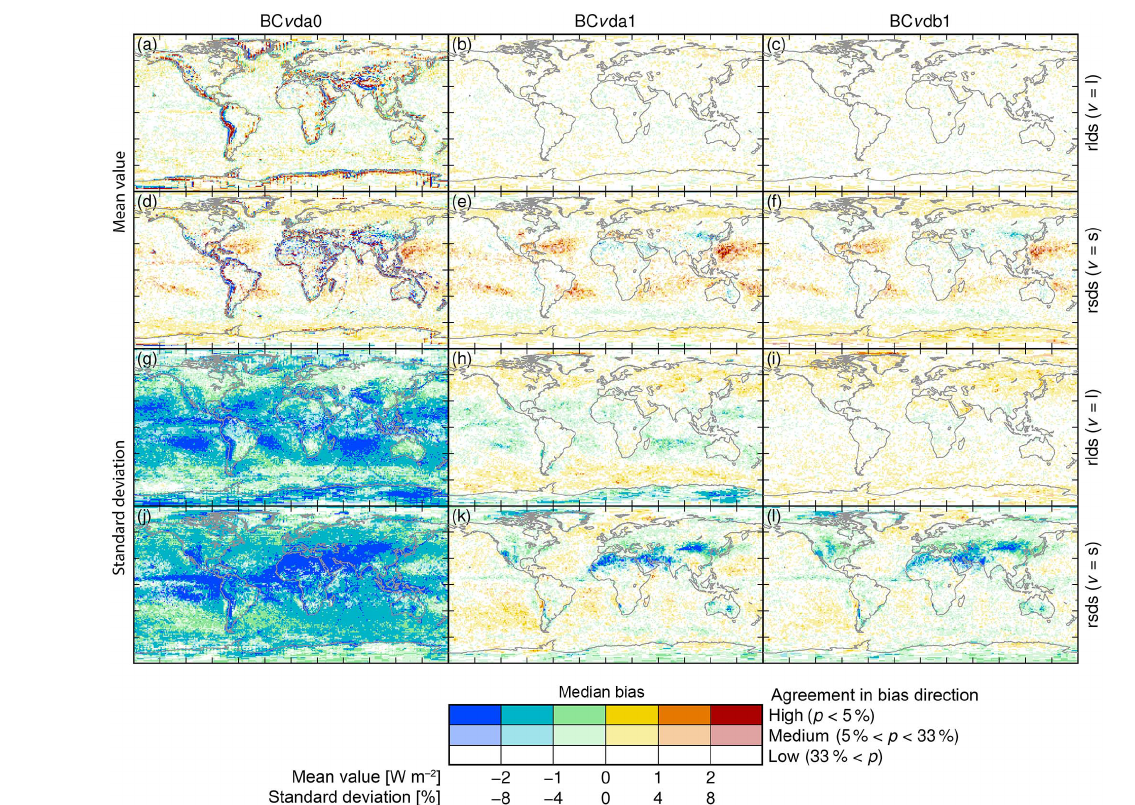
Figure 2. Biases relative to SRB in mean values ( a – f ) and standard deviations ( g – l ) of spatially aggregated (to the SRB grid) daily mean long- wave ( a – c , g – i ) and shortwave ( d – f , j – l ) radiation after bias correction with methods BC v da0 (left), BC v da1 (middle), and BC v db1 (right). The biases are calculated individually for each calendar month (January to December) and calibration data sample (every1st, every2nd) pooling SRB and corrected E2OBS data from all years of the corresponding validation data sample (every2nd, every1st, respectively) and omitting shortwave radiation data from months with monthly mean rsdt less than 1Wm − 2 (see Appendix B and Fig. D1c). Depicted are median and agreement in direction (sign of bias) of these individual biases, represented by hue and saturation of a grid cell’s colour, re- spectively. Categories of agreement in bias direction are defined based on one-sided p values obtained from modelling underestimations and overestimations for individual calendar months and validation data samples as outcomes of independent 50/50 Bernoulli trials. More saturated colours indicate higher statistical significance of biases remaining after bias